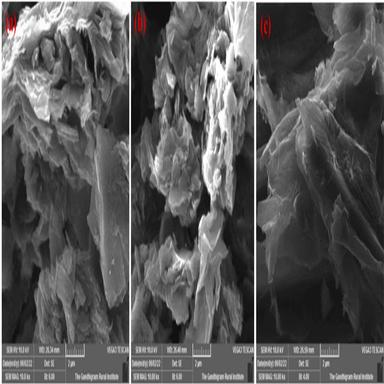
SEM Images depicting (a) Graphite, (b) Graphene Oxide (GO), and (c) the Fe-GO Nanocomposite.